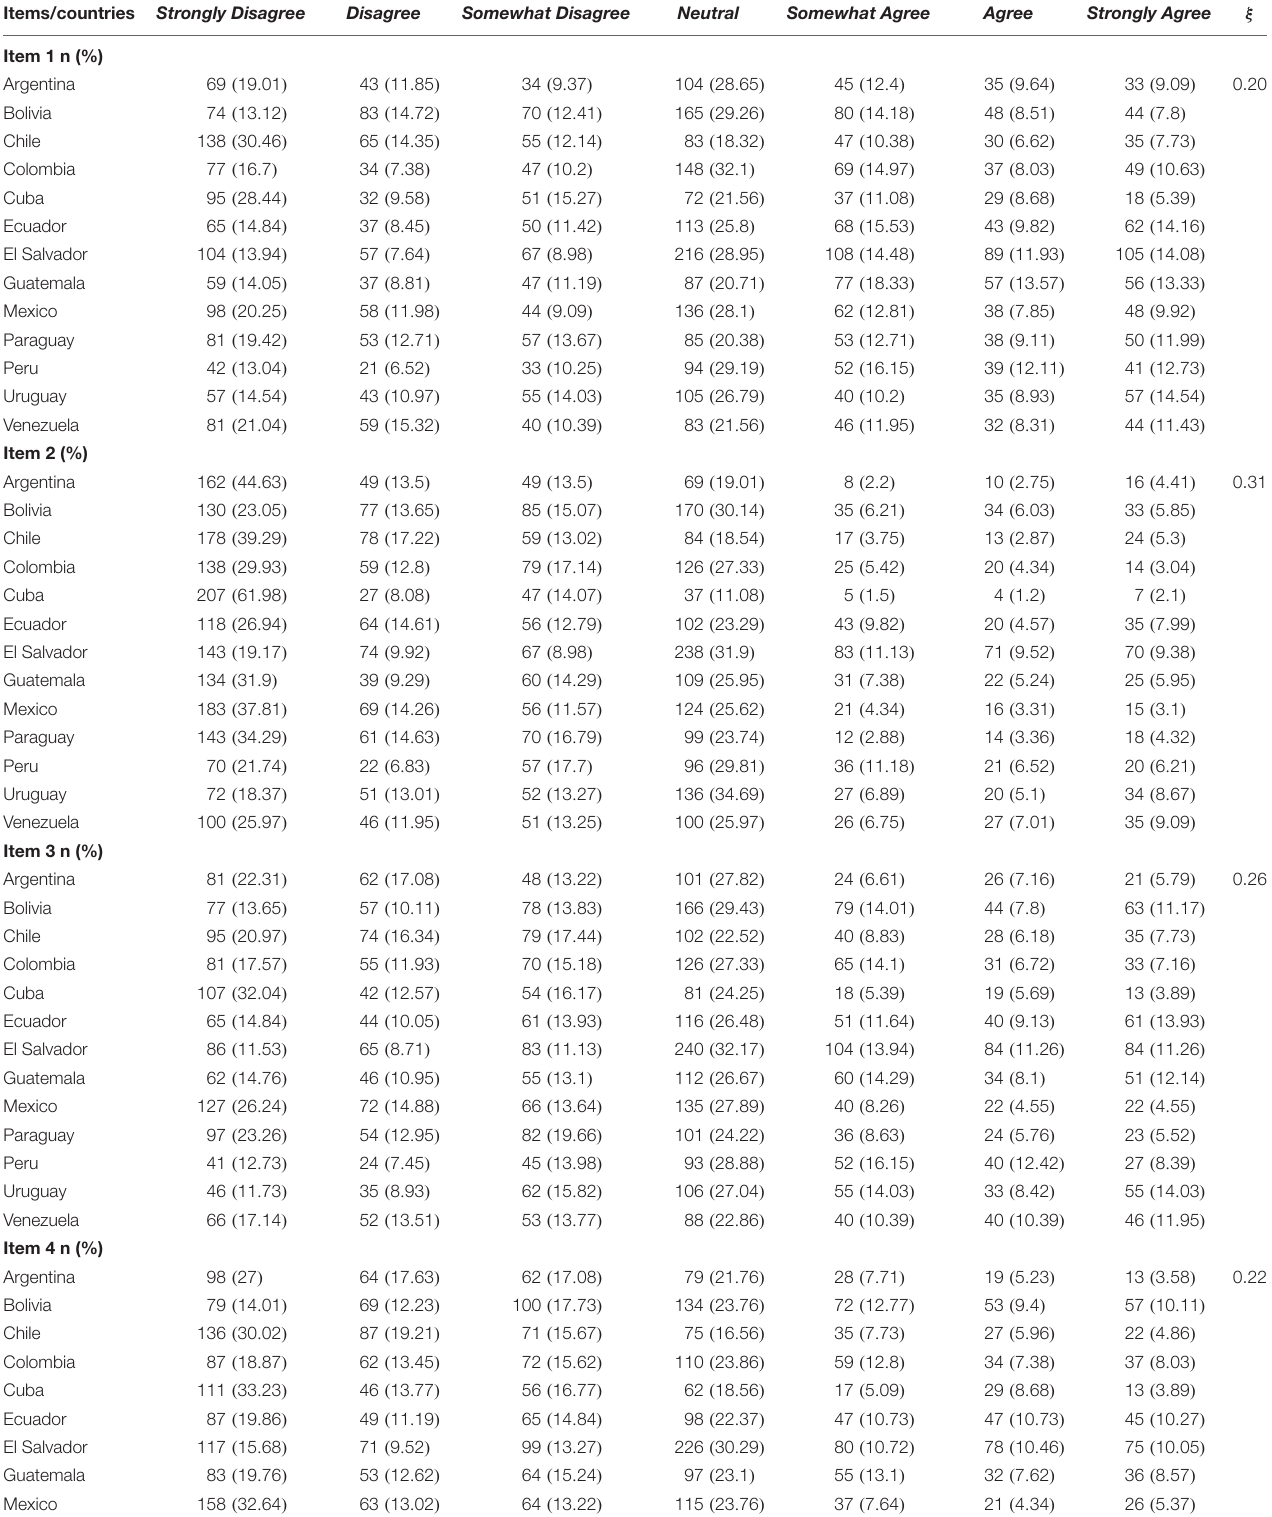
TABLE 3 | Response rates for each item and by